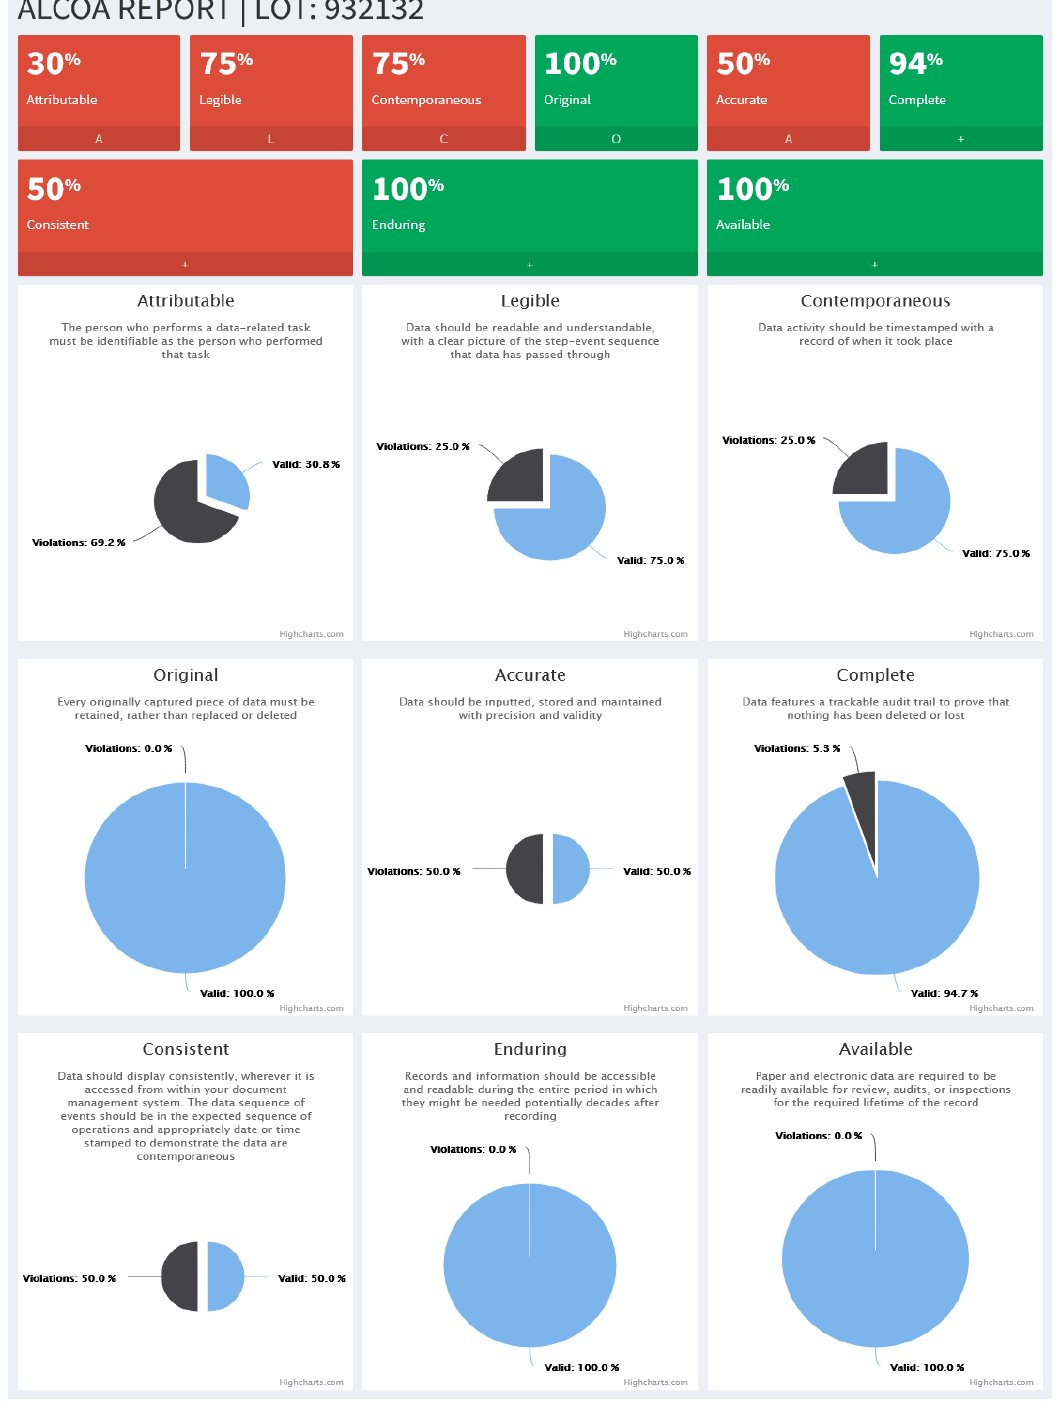
Figure 5. ALCOA violation data